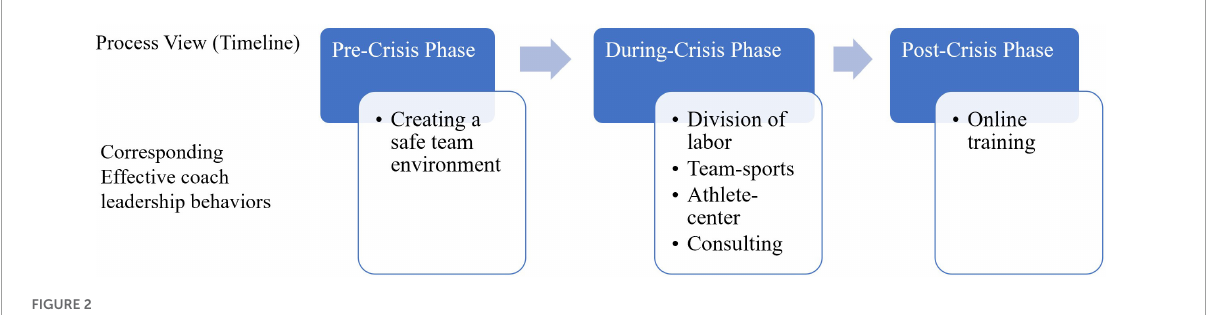
FIGURE2 Six pattern of effective coach crisis leadership behaviors with a process view.